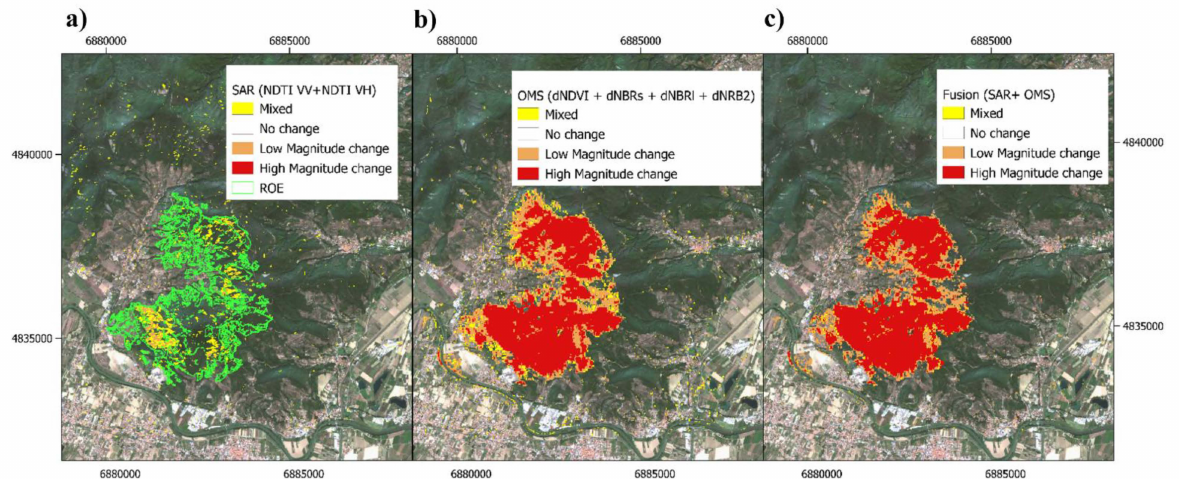
Figure 12. Burned-related change maps for the Monte Pisano case study obtained from ( a ) the OMS, ( b ) SAR, and ( c ) fusion datasets, in comparison to the Reference Observed Event (ROE) [45] (coordinate reference system: RDN2008/Italy zone (N-E)).